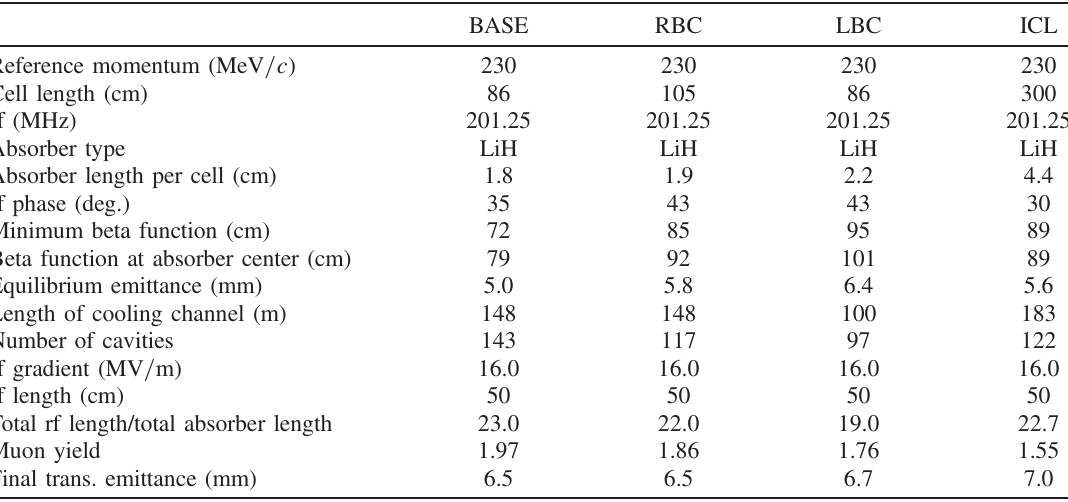
TABLE I. Lattice parameters of four alternative muon ionization cooling scenarios. Transverse beta functions are calculated at the reference momentum.